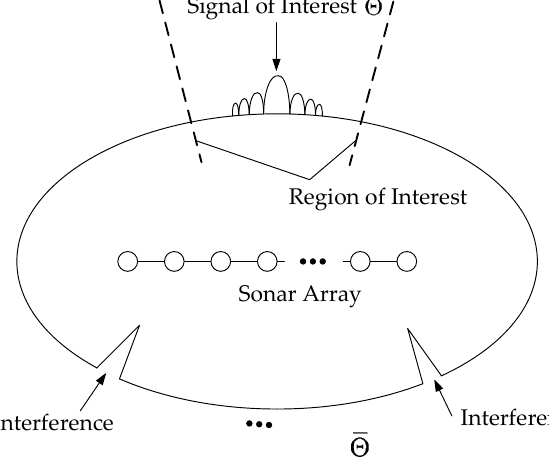
Figure 1. Depiction on array signal model.